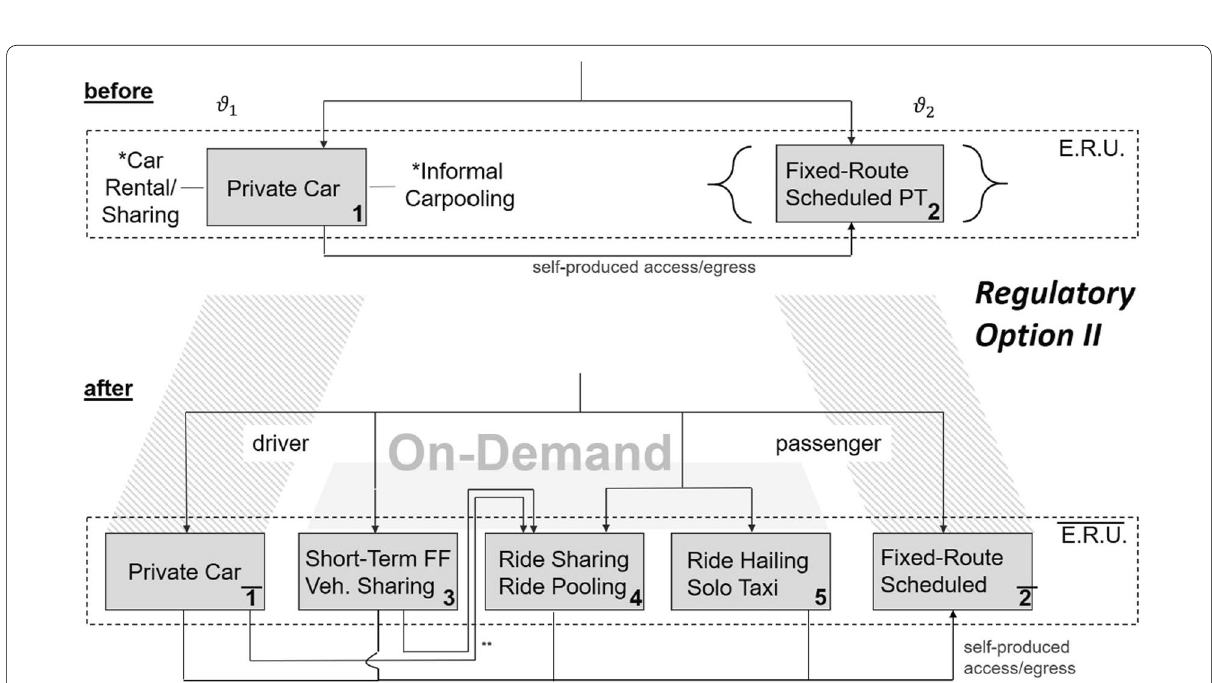
Fig. 2 Choice set formation before and after introduction of regulatory option